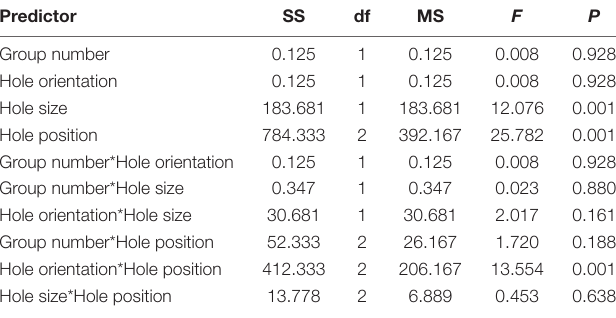
TABLE 1 | Results of the Experiment 1: evaluation of the influence of various predictors (group number, position, size, and orientation of the holes) on the number of passes, the factorial